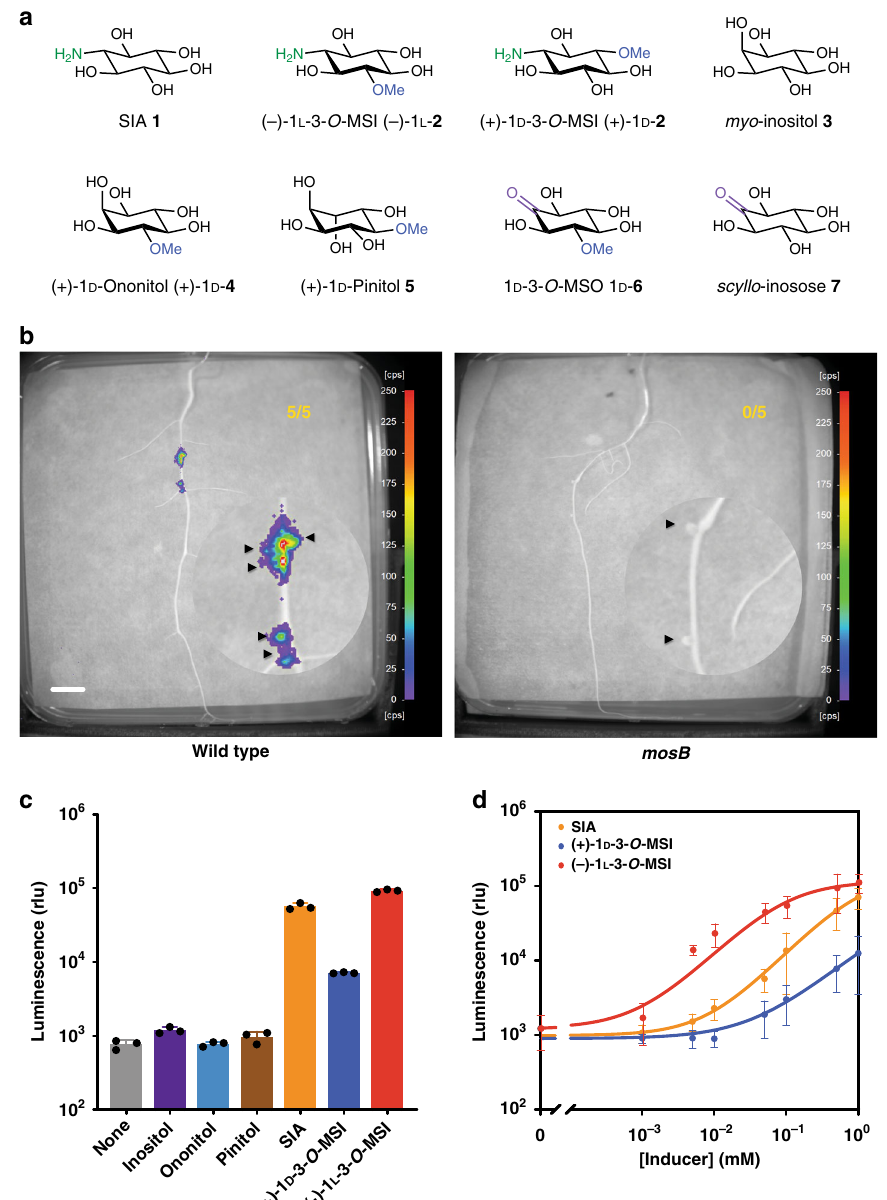
Fig. 1 Detection of rhizopine exudation with a rhizopine biosensor. a Chemical structures of rhizopines and related cyclitols. b NightOwl images of bioluminescence of R. leguminosarum Rlv3841/pOPS0046 rhizopine lux biosensor on the surface of M. sativa roots nodulated by S. meliloti L5-30 wild-type (rhizopine + ) and S. meliloti L5-30 mosB :pK19 (rhizopine – , see Fig. 2a). Numbers in top right corners indicate number of plants tested that showed signi fi cant levels of bioluminescence ( n = 5). Circle in bottom right corner contains magni fi ed image of a root section enriched with nodules. The positions of nodules are indicated with arrowheads (scale bar, 1 cm). Colours represent luminescence intensity from 0 counts per second (cool/purple) to 250 counts per second (warm/red). c Speci fi city of induction of rhizopine lux biosensor with rhizopines compared to other chemically similar plant polyols, grown in UMS minimal medium with pyruvate and ammonia as carbon and nitrogen sources, supplemented with 1 mM of inducing molecule. Data are presented as relative luminescence units (rlu). Black dots indicate individual data points for each condition. d Induction curves showing the dynamic range and sensitivity of the rhizopine lux biosensor with chemically synthesised SIA 1 , ( − )-1 L -3- O -MSI ( − )-1 L - 2 and ( + )-1 D -3- O -MSI ( + )-1 D - 2 grown in UMS minimal medium with pyruvate and ammonia as carbon and nitrogen sources. Error bars represent standard deviation of the mean of n = 3 independent replicates. All experiments were repeated at least three independent